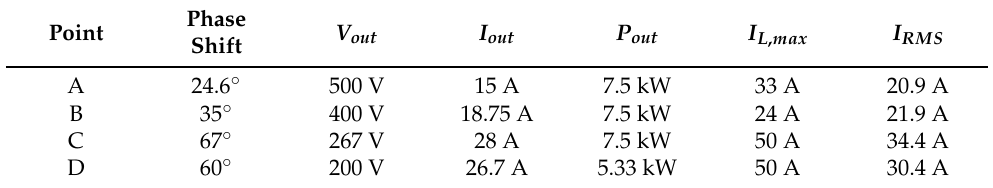
Figure 9. Primary current and primary/secondary voltages for the four operating points specified in Figure 8. Table 6. Main simulation results for the operating points specified in Figure